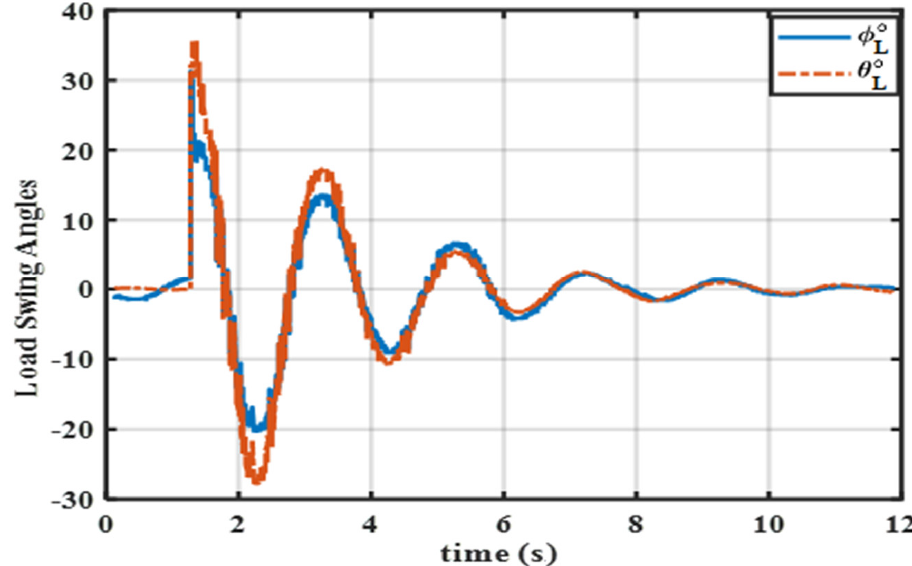
Figure 18. Time history of the load swing angle during hover with the ASC .